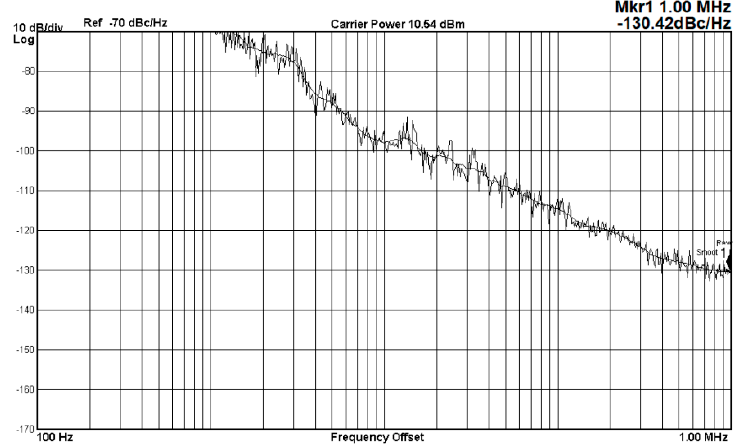
Figure 8. Phase noise measurement results of the proposed DCO divide-by-64 output when operating at the lowest operating frequency (144.6 MHz). Measurements were performed using Keysight Technologies N9010A EXA signal analyzer.